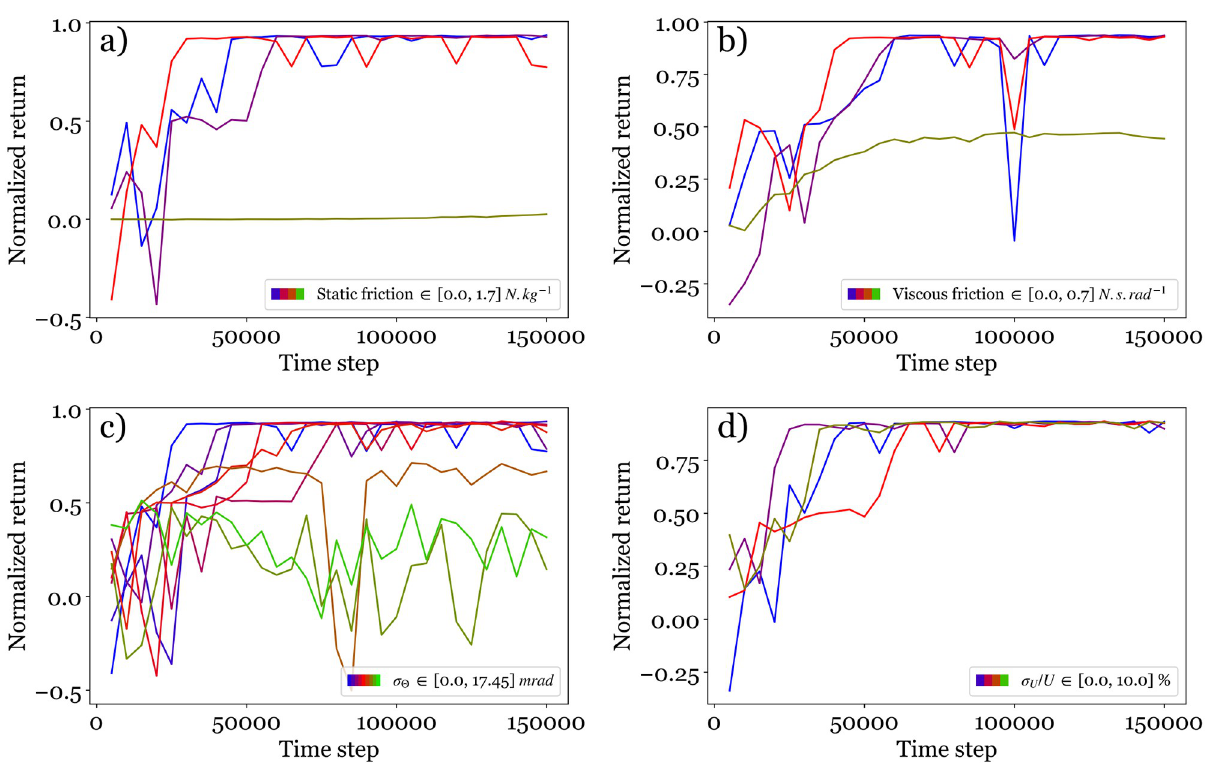
Fig 7. Influence of the physical parameters on the control: Inference curves of a) static friction, b) viscous friction, c) measurement noise and d) action noise.